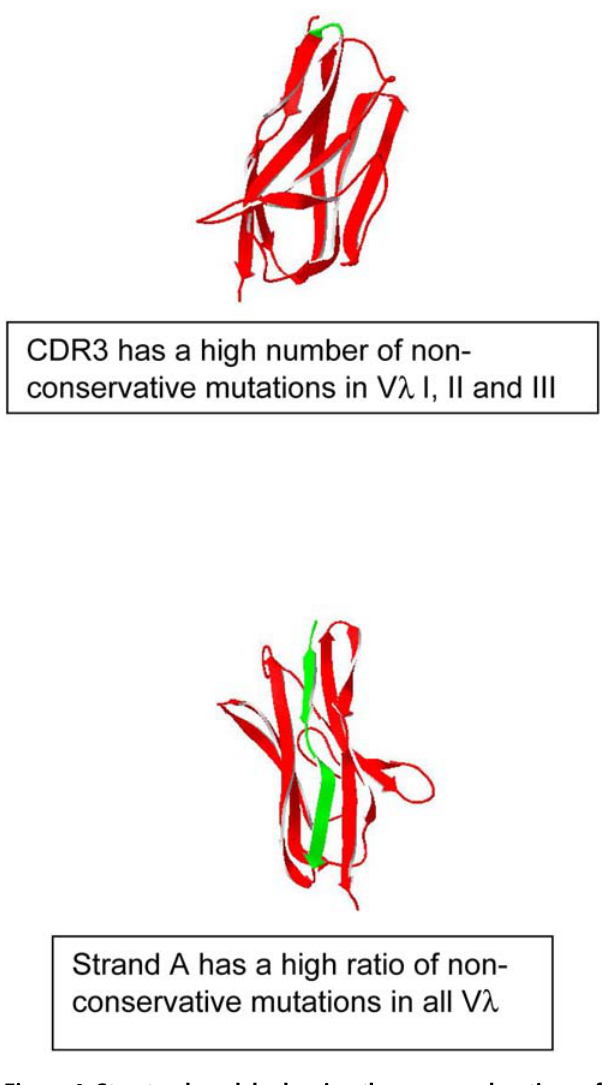
Figure 4. Structural models showing the common locations of non-conservative mutations in ALV l proteins in our study. Protein models were based on the crystal structure for V l VI germline (2CDO.pdb). The b -strands in the structure are shown as red ribbons; mutation regions discussed in the captions are shown in green.